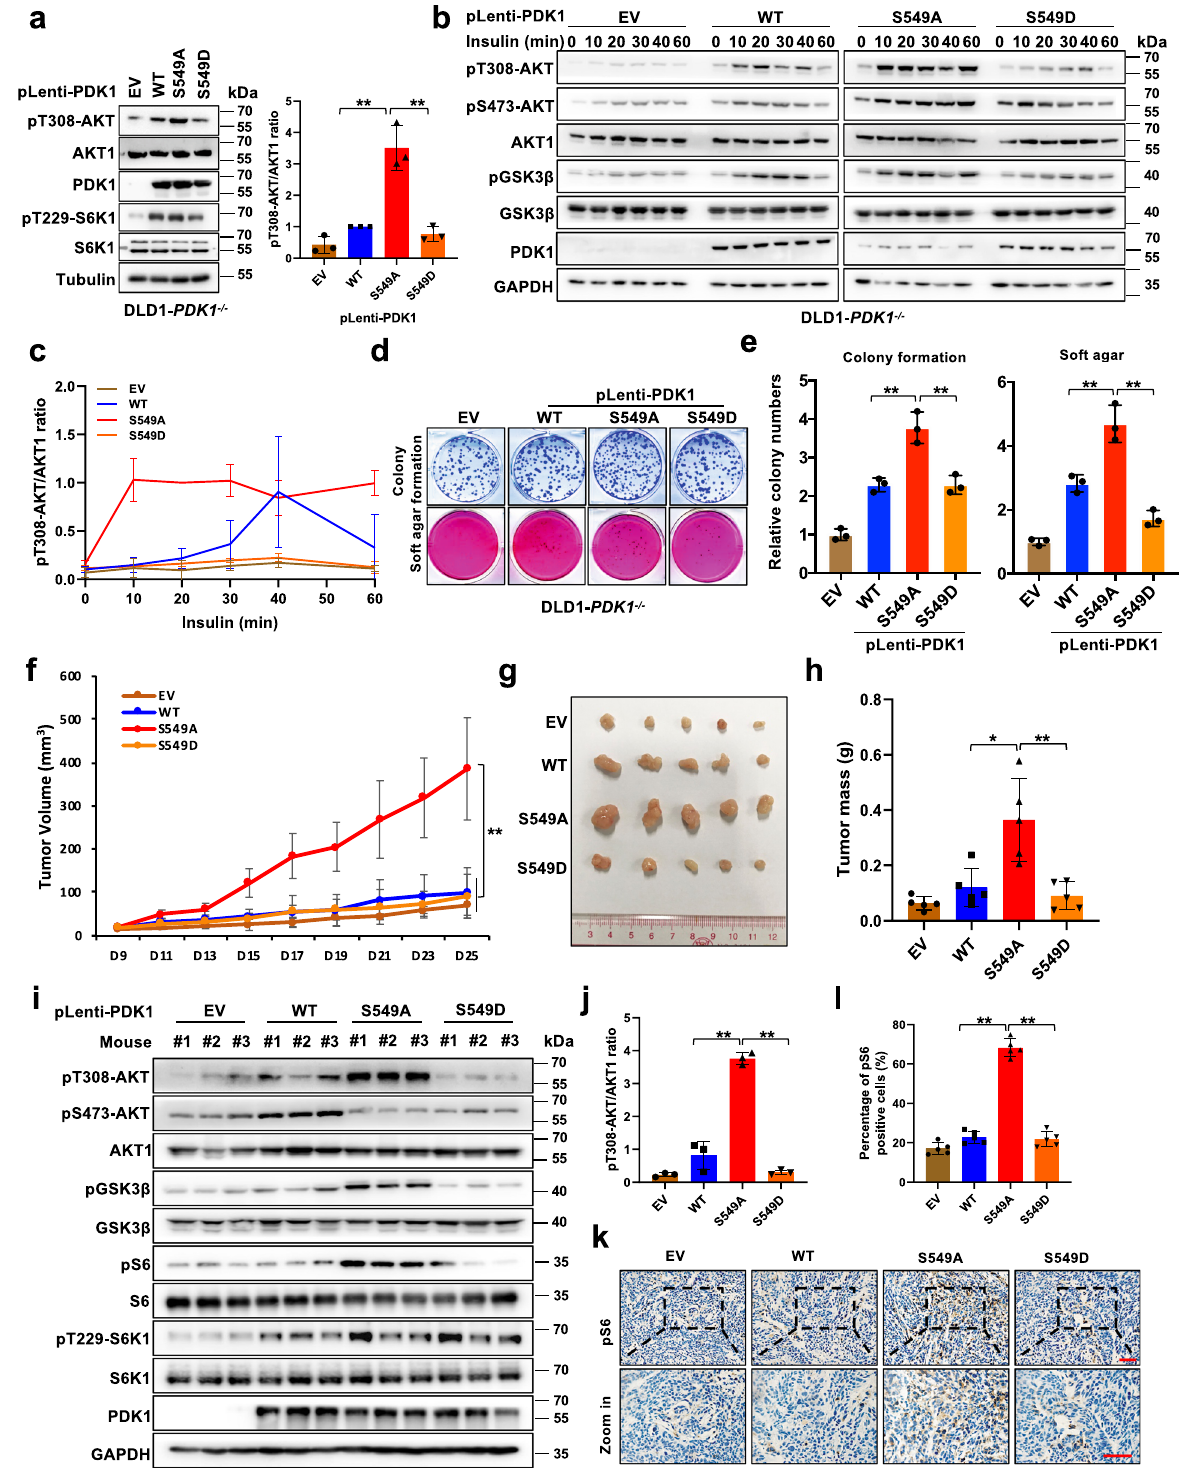
intended to evaluate whether S6K1-mediated PDK1 phosphor- that PDK1 homo-dimerization was markedly enriched following ectopic expression of a dose-increased S6K1-R3A (Supplementary Fig. 6h), or phospho-mimetic mutant PDK1-S549D (Supplemen- tary Fig. 6i). These results implicate that S6K1-mediated PDK1 phosphorylation enhances its dimerization and contributes to the negative regulation of AKT